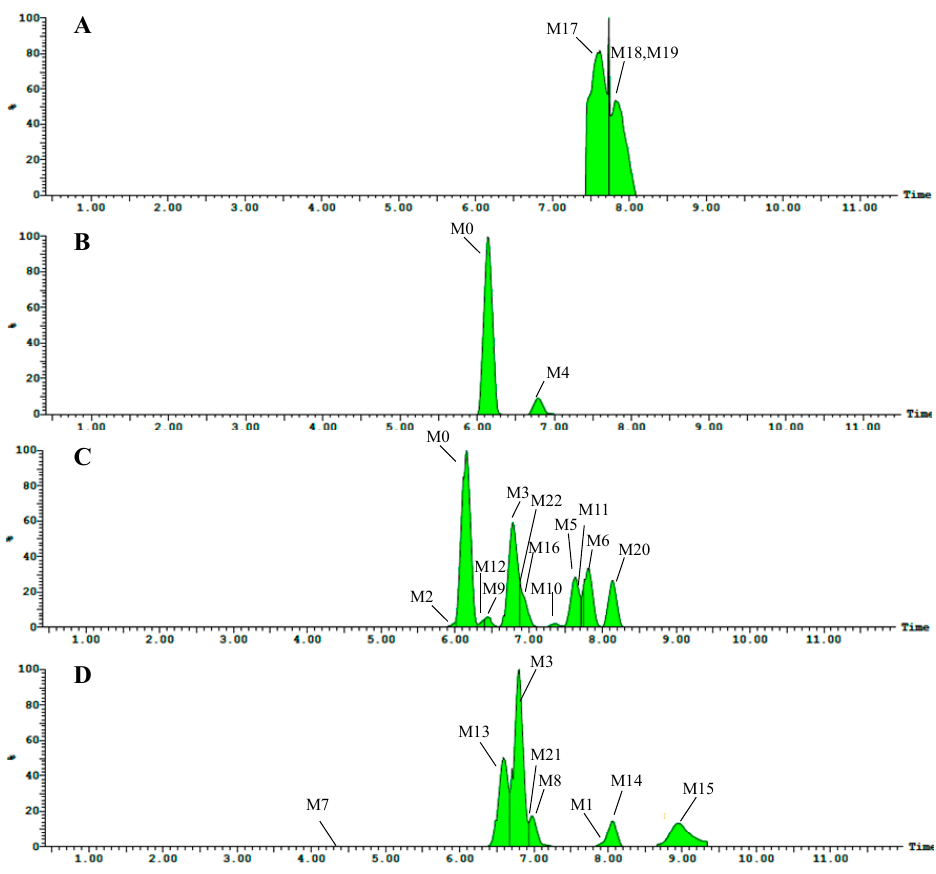
Figure 2. Representative TIC chromatograms of rat samples after intragastric administration of astragaloside IV at 80 mg/kg. ( A ) plasma; ( B ) bile; ( C ) urine; ( D ) feces.